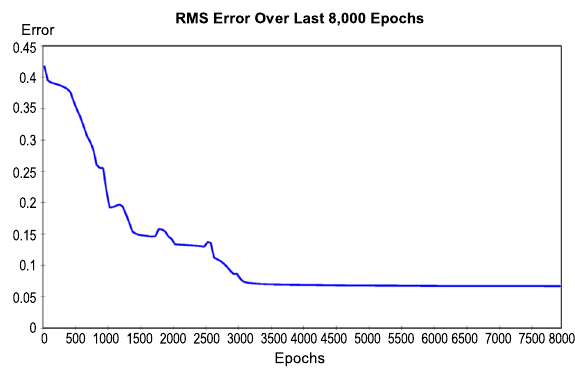
Fig. 4. Training curve of the ANN